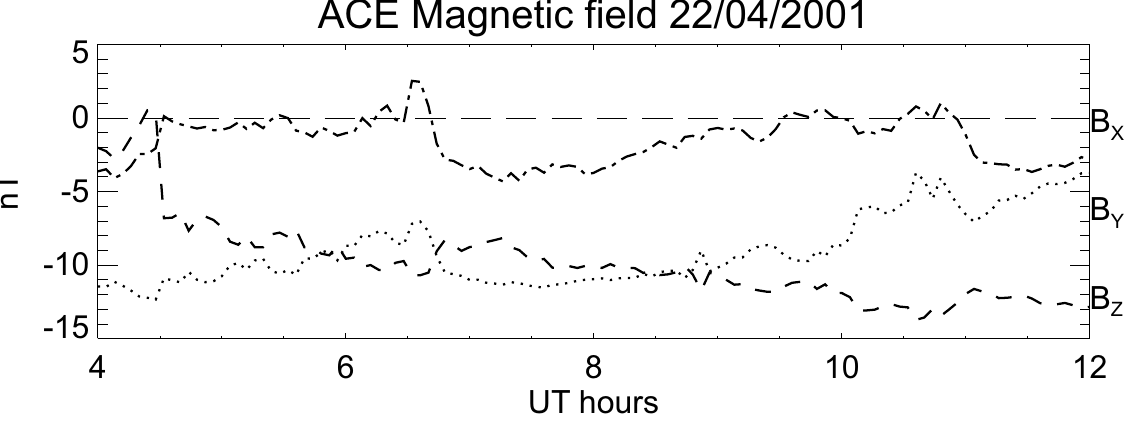
Fig. 6. The 4-min averaged measurements of the interplanetary magnetic field from the ACE spacecraft are displayed. Components, B X (dash-dotted line), B Y (dotted line), and B Z (dashed line), in the GSM coordinate system are shown. A delay of 1h is included in the time shown for the measurements to account for the solar wind propagation from the spacecraft to the